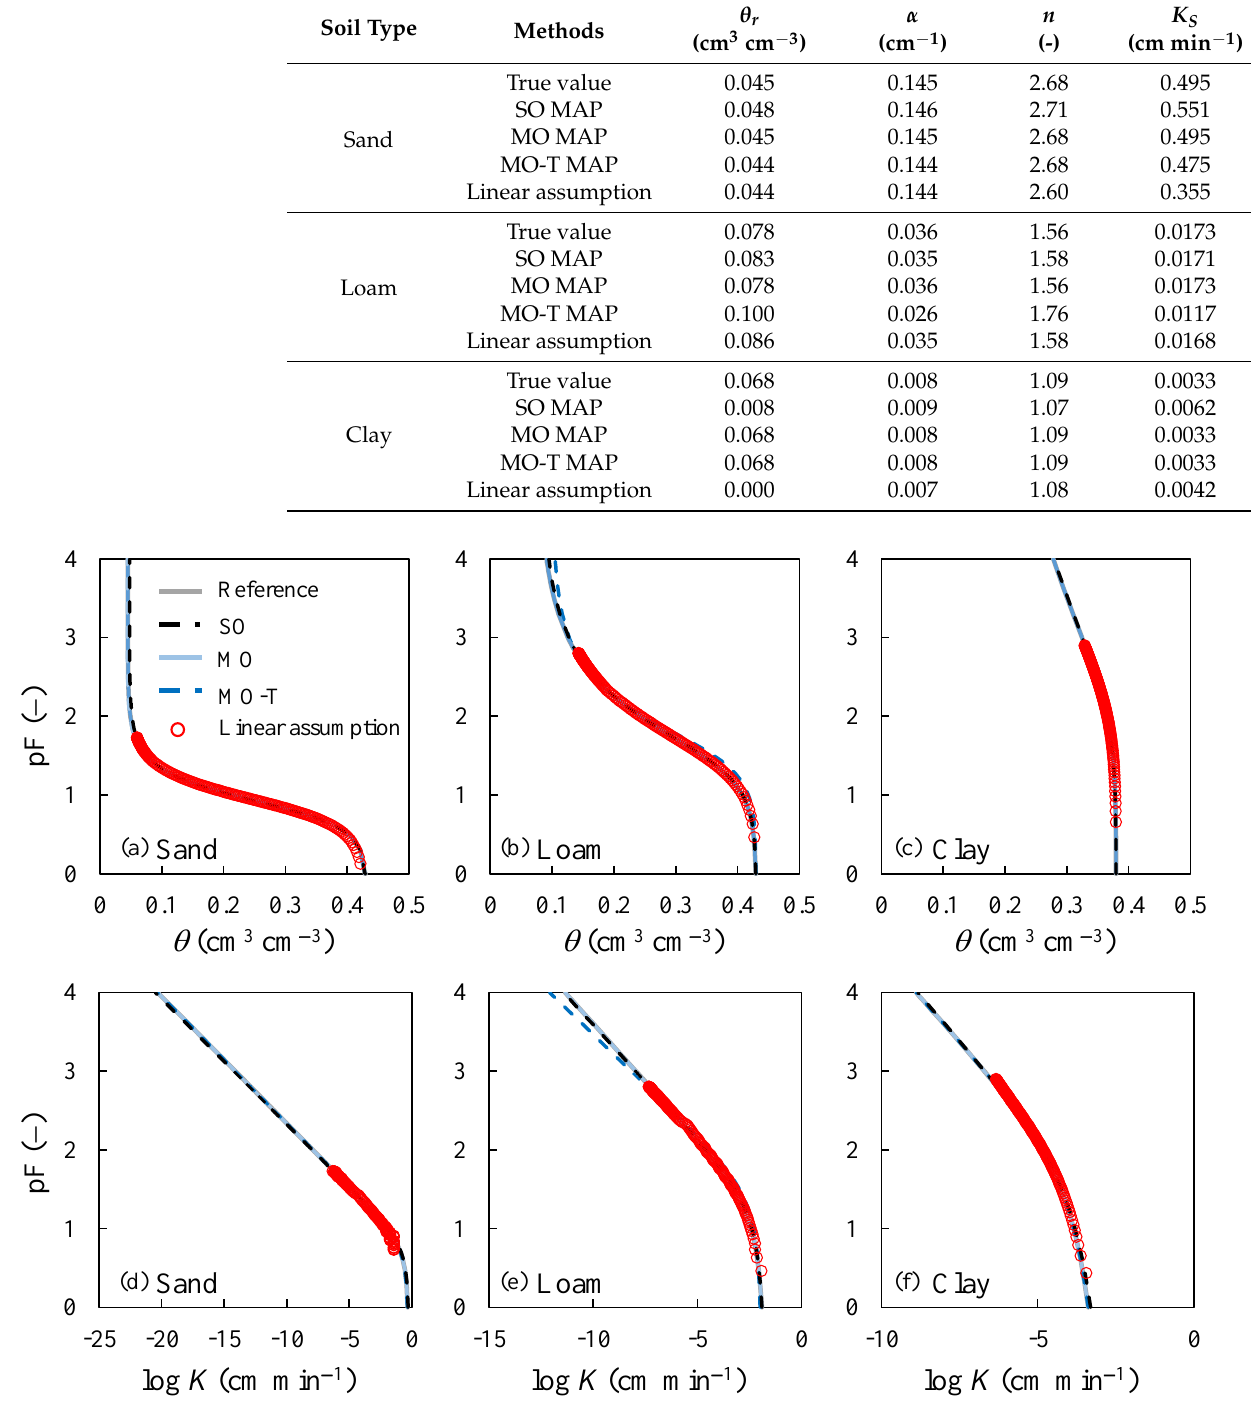
Table 2. Soil hydraulic parameters that were obtained with different methods for the three syn- thetic examples.